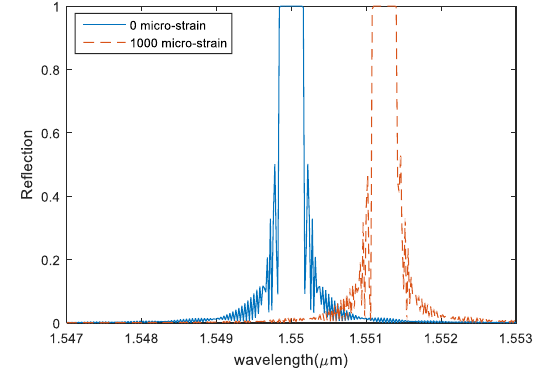
Figure 4: Reflection response of FBG initial structure as a function of applied